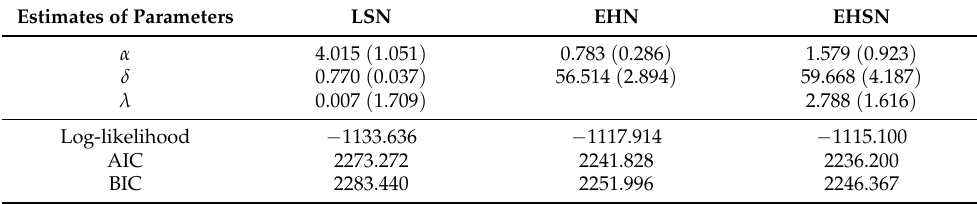
Table 5. Estimates of parameters in EHN and EHSN models for volcanoes